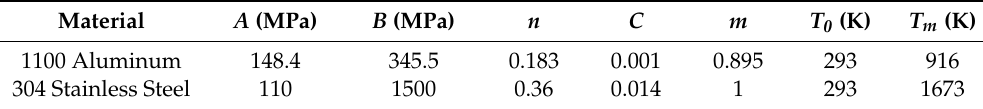
Table 3. J-C parameters [32], with permission from Elsevier,